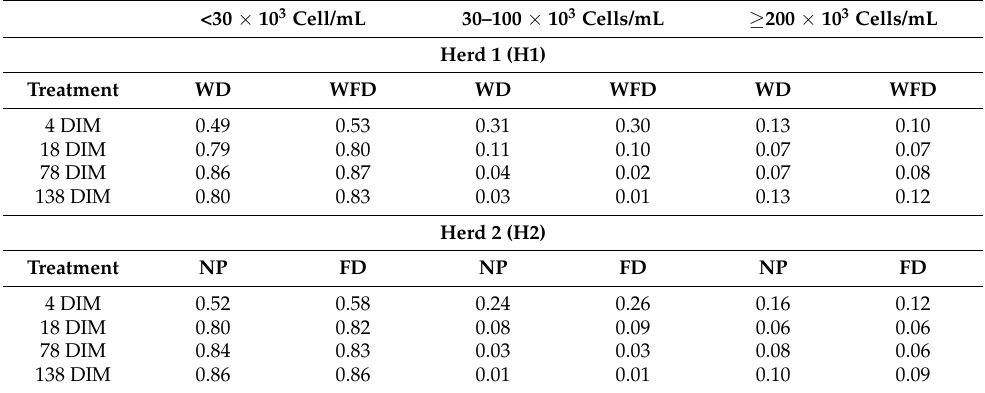
Table 2. The proportion of quarters (number of quarters) from two herds (H1 and H2) for four pre-milking teat treatments (H1: WD and WFD, H2: NP and FD) with a somatic cell count (SCC) within categories, <30 × 10 3 , 30–100 × 10 3 and ≥ 200 × 10 3 cells/mL, across four sampling